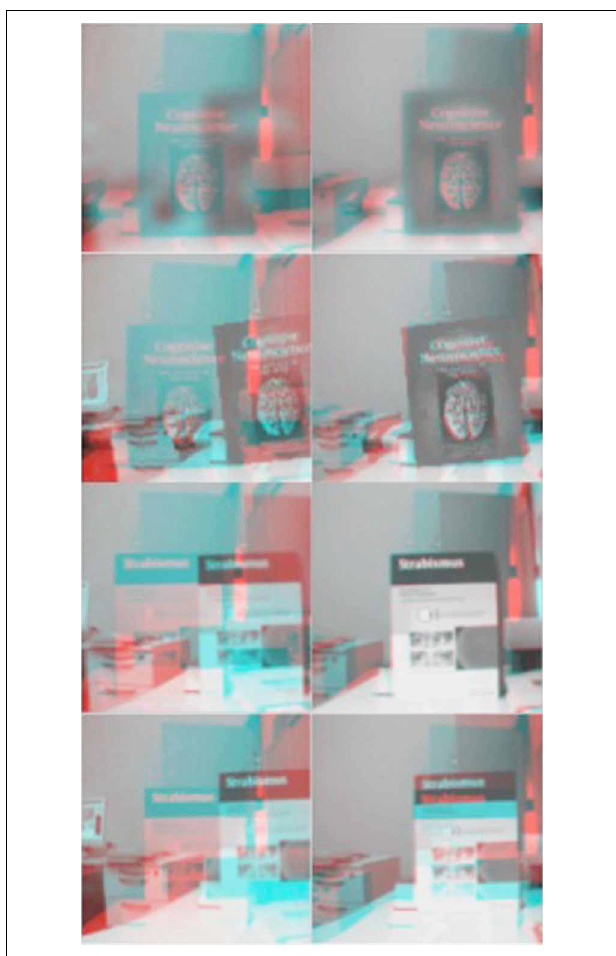
FIGURE 8 | Test on the real iCub. Anaglyph of left and right image, before (left) and after (right) vergence is achieved for each perturbation (from top to bottom: Blur of σ = 4 px; Roll of 5 ◦ ; Pan of 4 ◦ ; Tilt of 2 ◦ ). See also online video (Lonini et al.,